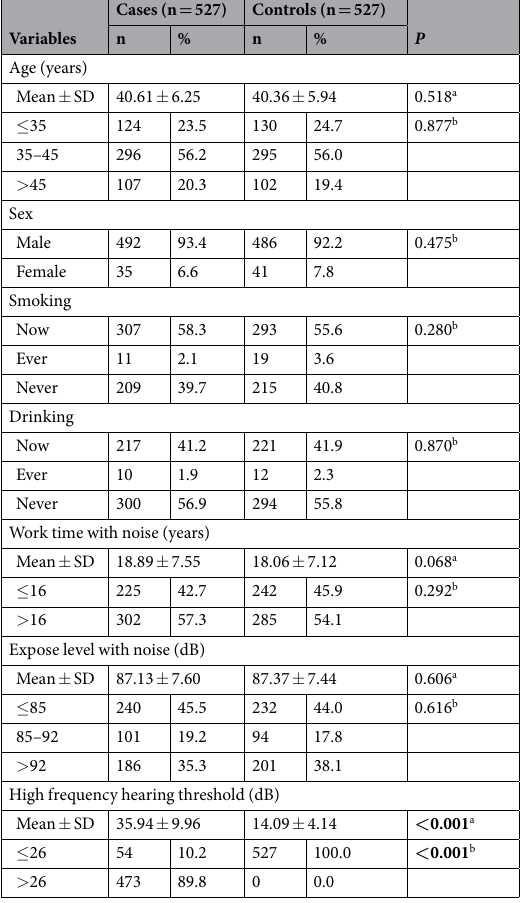
Table 1. Demographic characteristics of study subjects. a Students’ t-test. b Two-sided χ 2